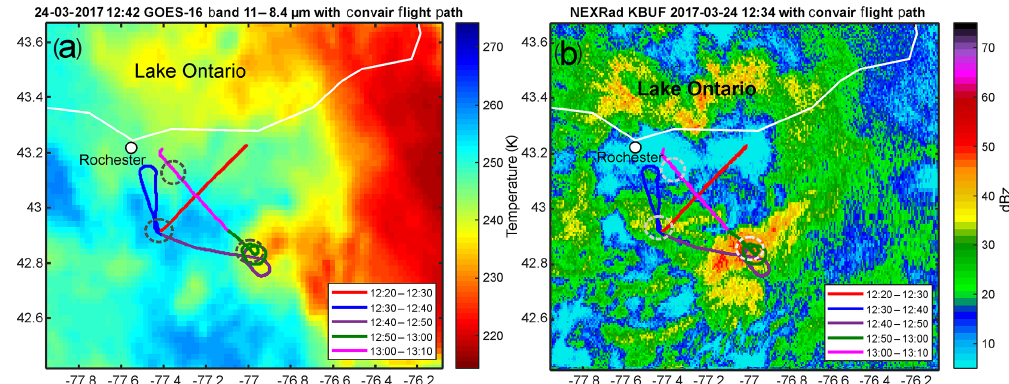
Figure 12. Flight track of the Convair 580 in the frontal cloud system on 24 March 2017 overplayed over (a) GOES-16 infrared image (download from University of Wisconsin); (b) KBUF (Buffalo, NY) NEXRAD reflectivity at elevation 0.46 ◦ . Dashed line circles indicate SIP cloud